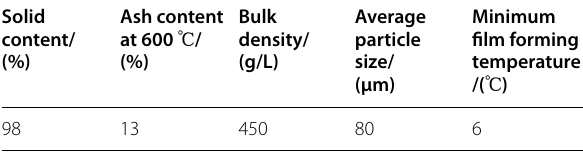
Table 4 Performance indexes of redispersible latex powder Solid Ash content content/ at 600 ℃ / (%)